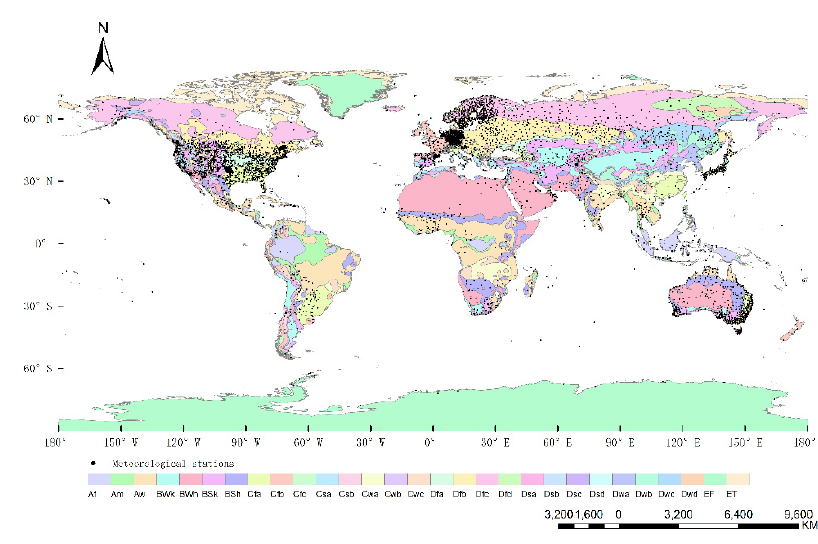
Figure 1. Spatial distribution of the meteorological stations used in this